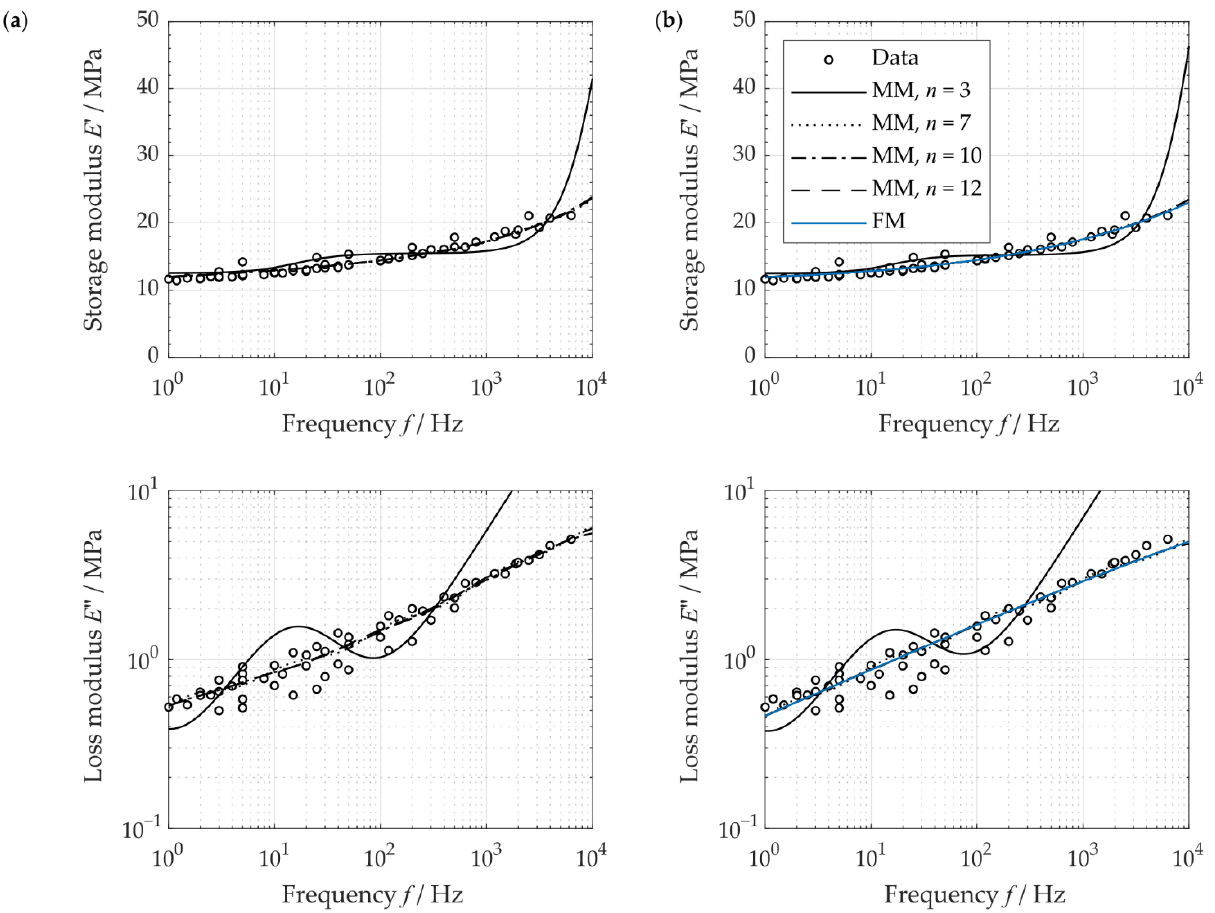
Figure 7. Approximated storage and loss modulus using generalized Maxwell models and a fractional model: ( a ) Prony series without pre-smoothing, ( b ) Prony series with pre-smoothing. It can be seen that the approximation ability increased with an increasing number of Maxwell elements. Furthermore, the resulting error measure decreased (Table 2). The relaxation moduli obtained similar results for the different number of Maxwell elements n